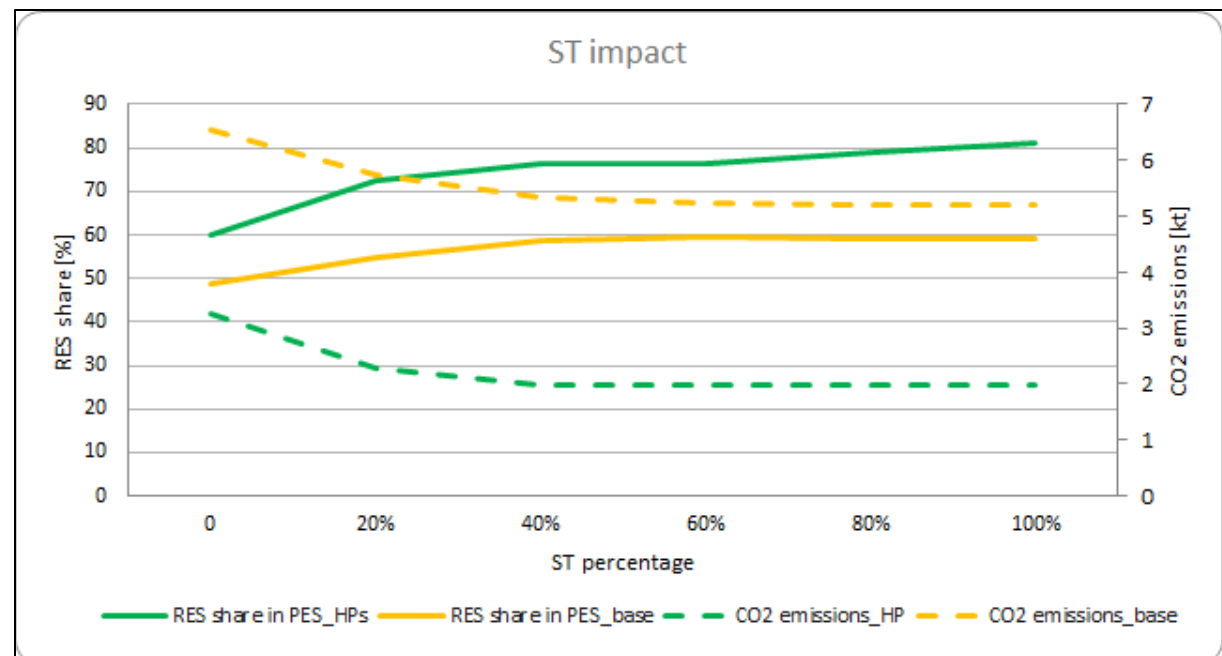
Figure 12. Analysis of the impact of solar thermal collectors on the system emissions (right axis) and RES share in PES (left axis).